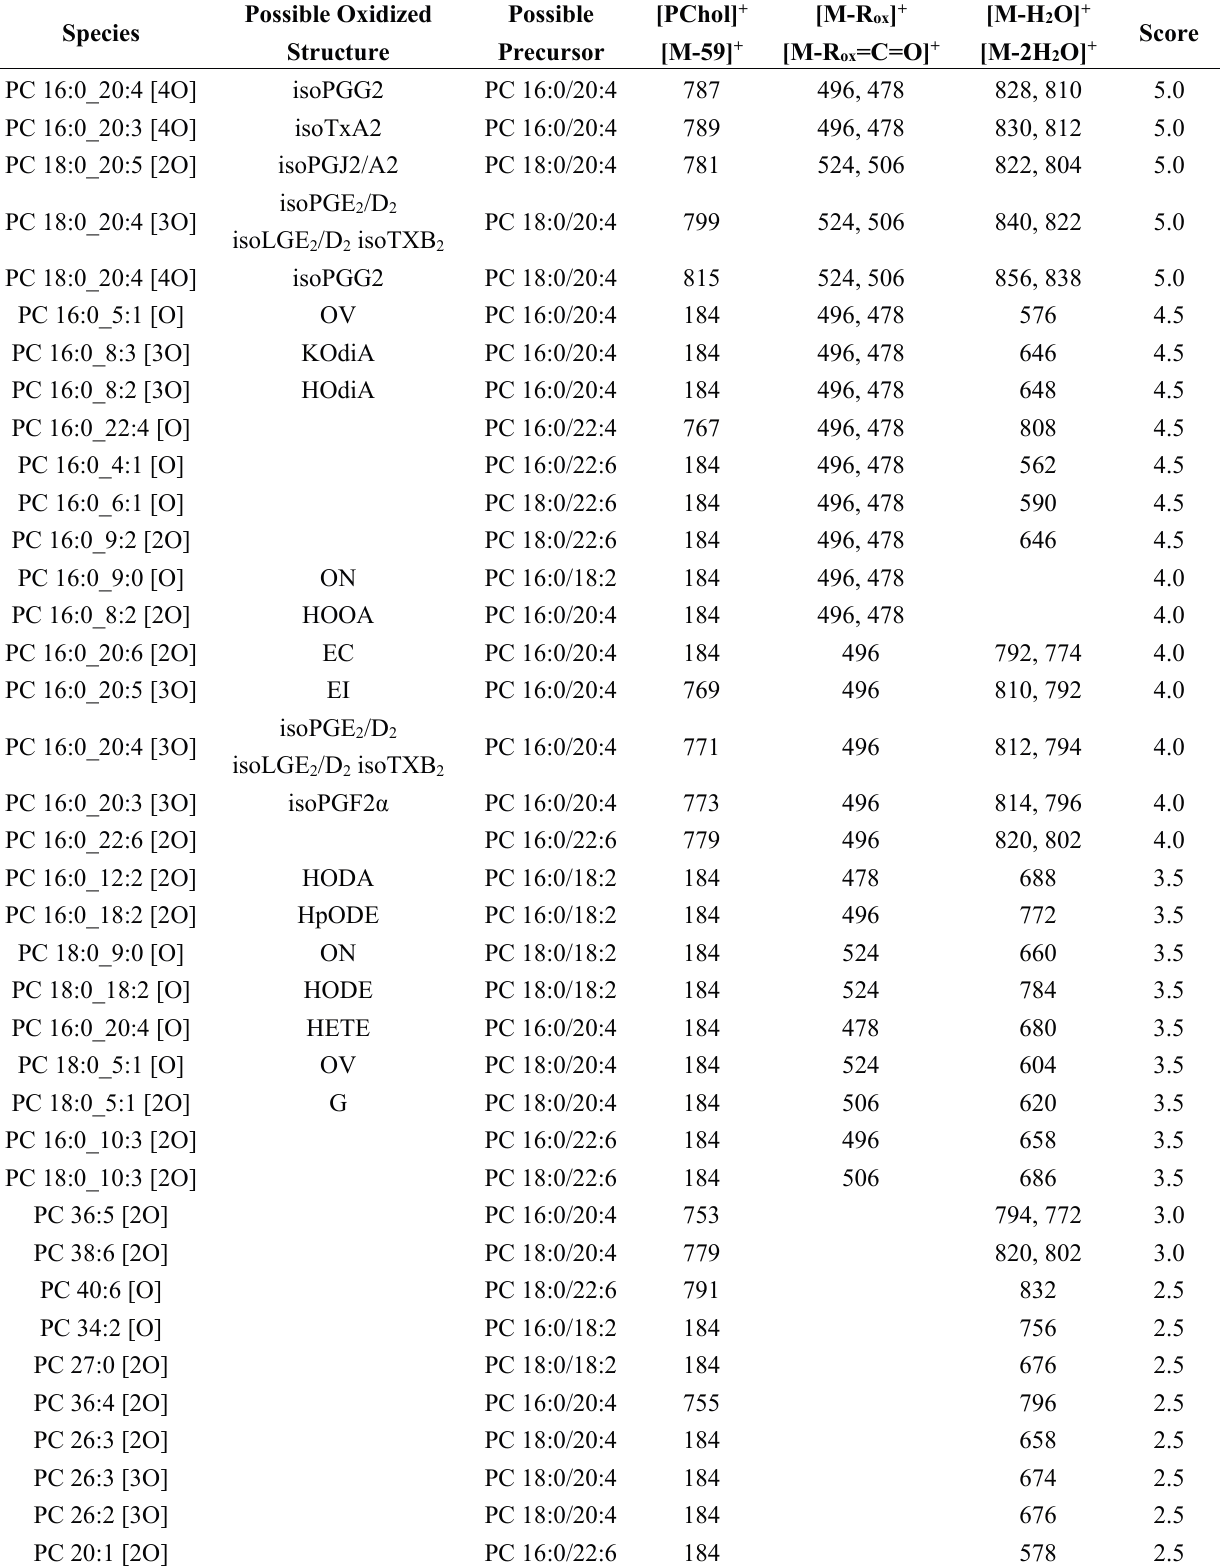
Table 3. List of detected fragments in oxidized LDL including assignment of possible non-oxidized precursors and oxidized PC structures reported in the literature for the corresponding shorthand denoted compounds. Abbreviations of oxidized structures are explained in Supplementary Table